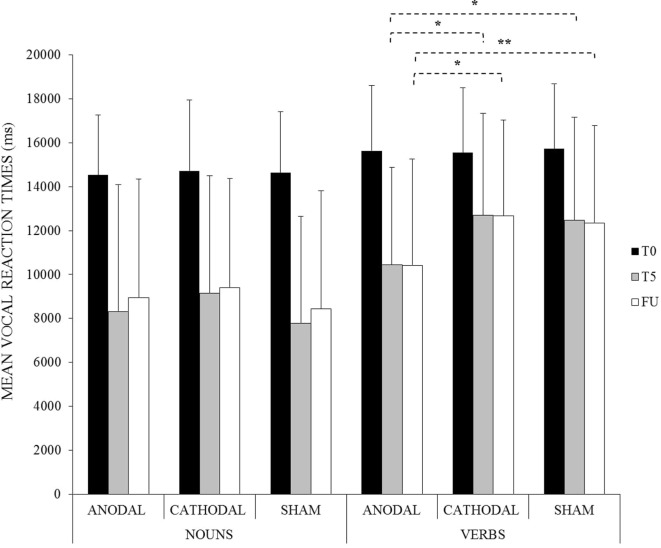
Mean vocal reaction times for noun and verb naming at baseline (T0), at the end of the treatment (T5) and at follow-up (FU) for the anodal, cathodal, and sham condition, respectively (*<0.001, **<0.01). Error bars represent SD.